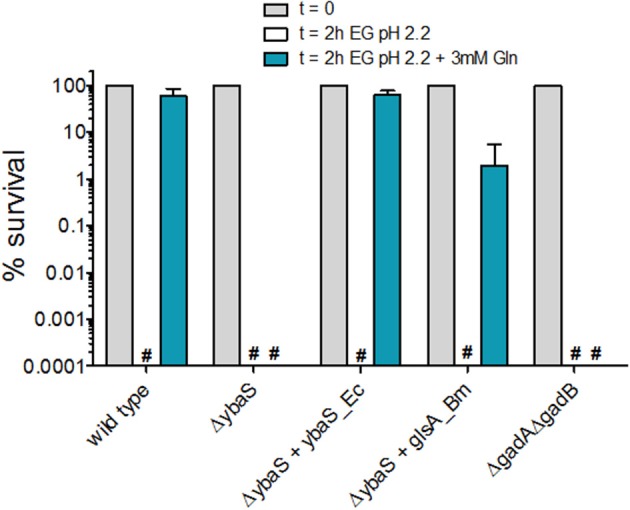
Effect of Gln addition to EG minimal medium at pH 2.2 on the survival of E. coli MG1655 and its isogenic mutant strains. Residual viability of stationary-phase cultures of the indicated strains, diluted 1:4000 in EG pH 2.2 and incubated (statically) for 2 h at 37°C. Following the acid challenge, viability was expressed as % CFU/ml on a log10 scale, compared to bacteria present at time zero. The data represent the mean (SD) of 3–6 independent experiments. The hashtag indicates no survivors detected. The complemented strains carried the relevant gene cloned into plasmid pBBR1MCS. For consistency, the empty plasmid was also carried by the mutant strains.